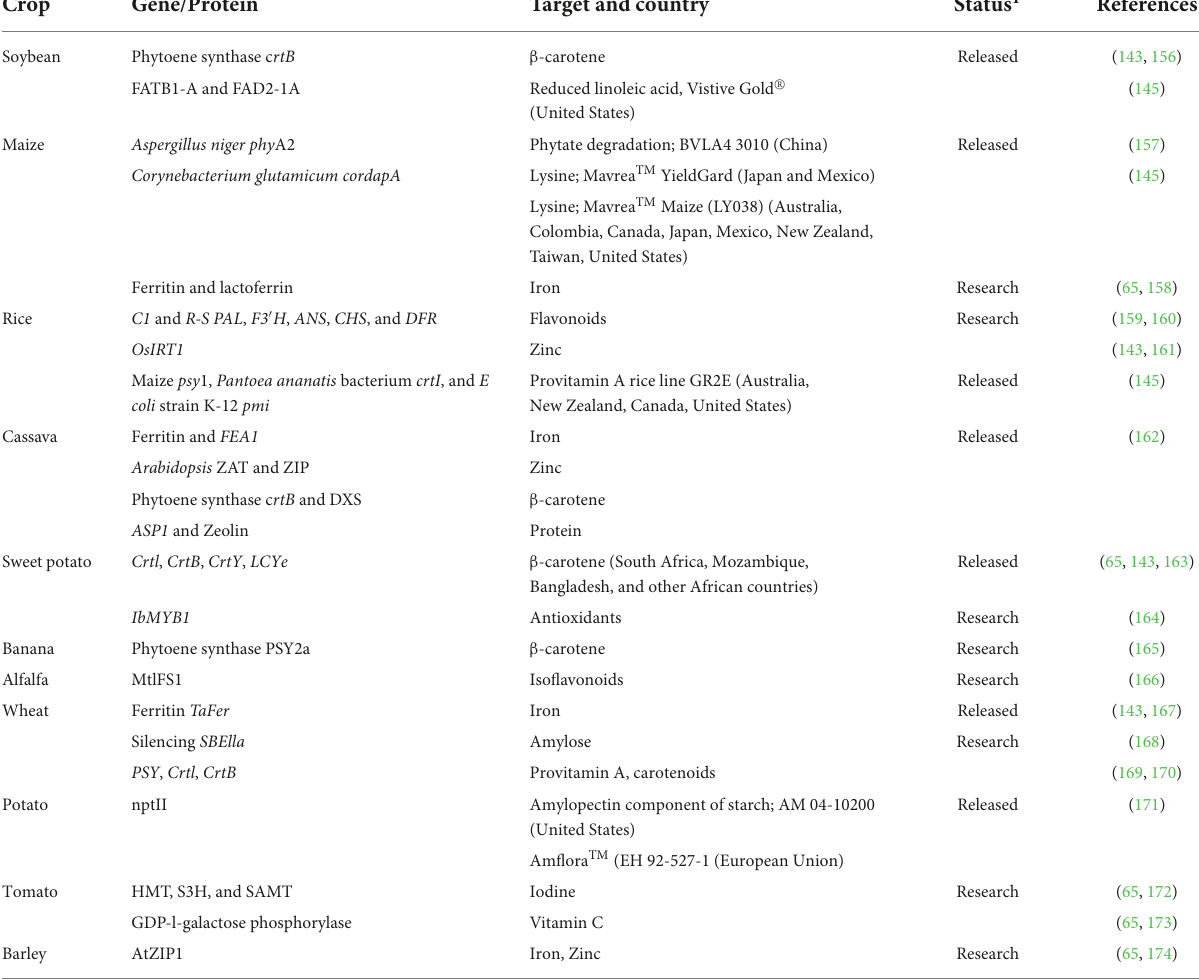
TABLE 2 Some examples of biofortified crops produced by